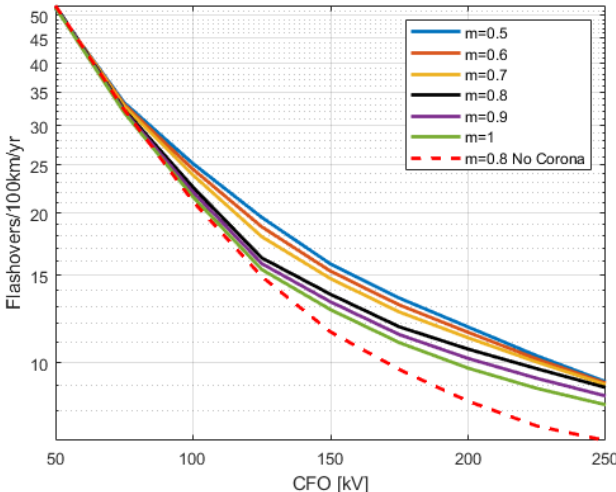
Figure 3. Comparison of the lightning performance of an overhead distribution line with different surface state conditions—the red dot line represents the case when the corona effect is not considered.